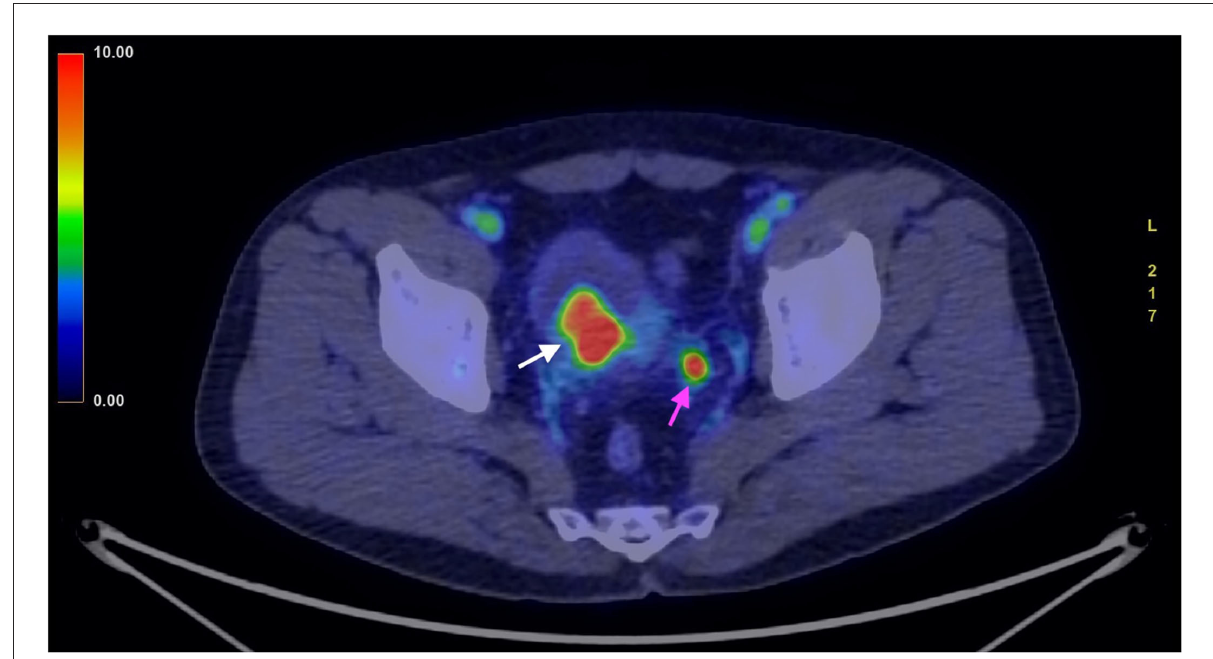
FIGURE3 FDG PET/CT (image fusion technique) acquired in an early phase, 3min after administration of the 18 FDG. The image shows intense uptake of the 18 FDG by the tumor (white arrow). The smaller high uptake spot on the left corresponds to physiological collection of urine within the ureter (purple